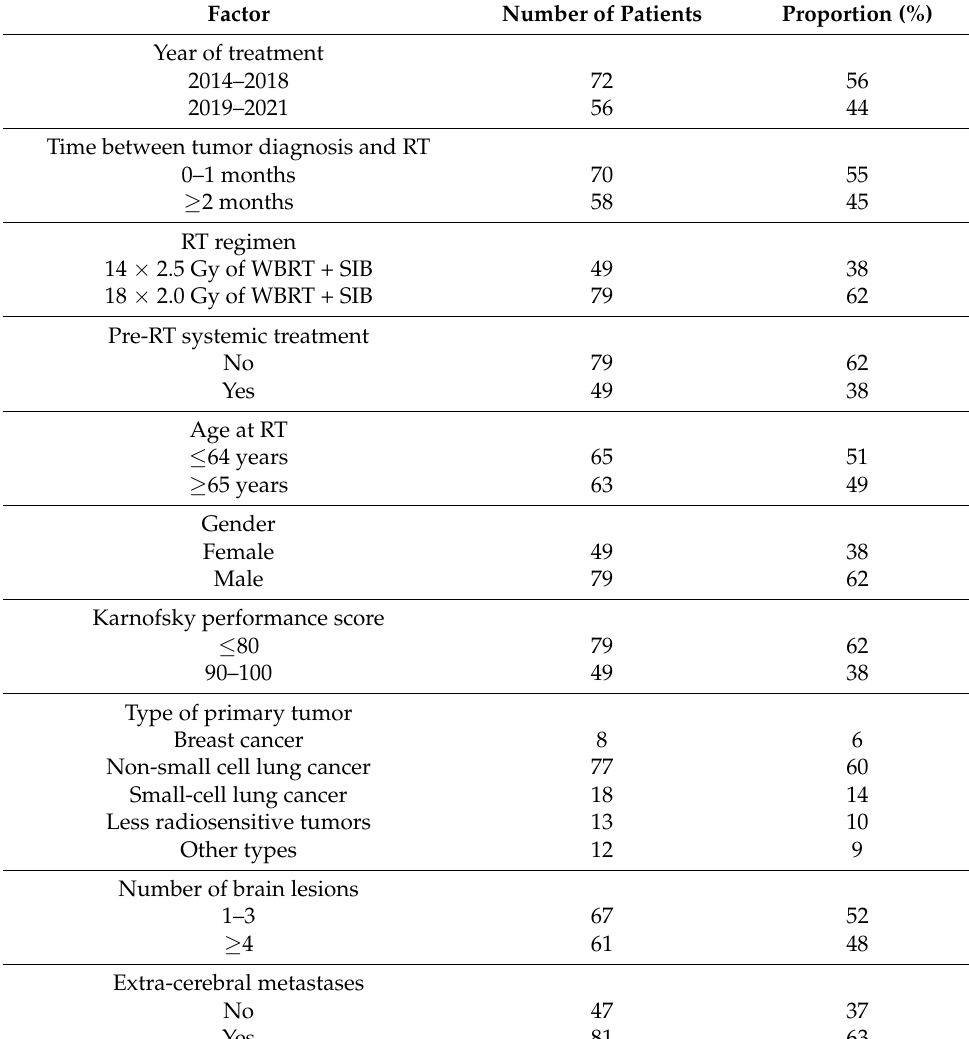
Table 1. Distribution of the factors analyzed for